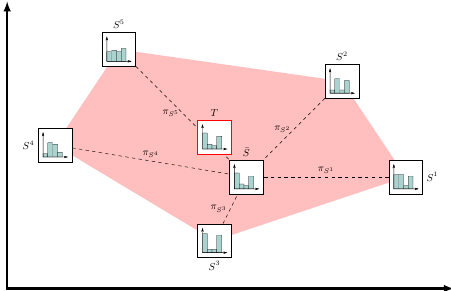
Figure 2. A synthesized source ¯ S is formed as the convex combination of candidate sources S s